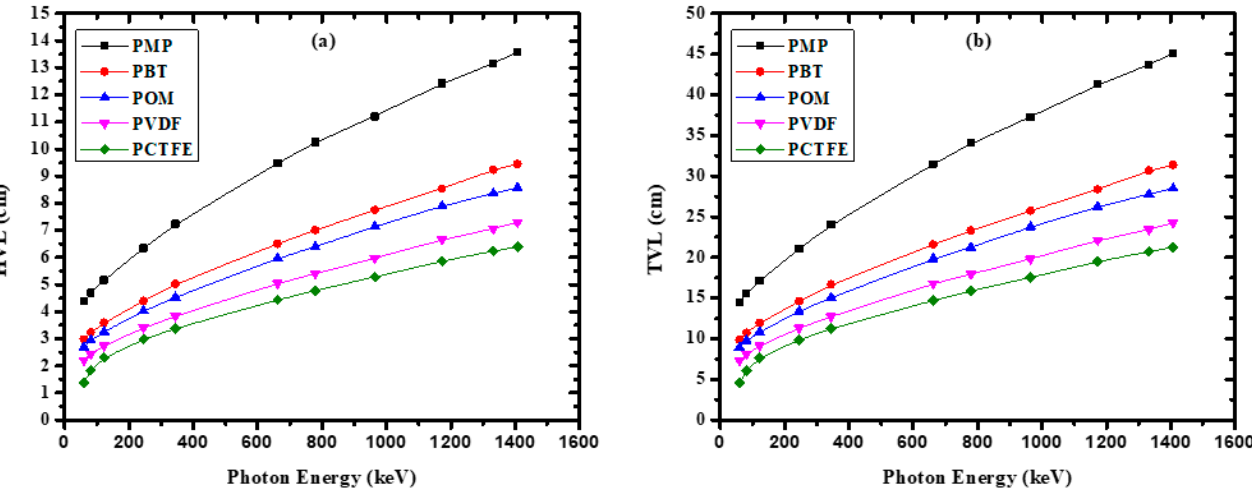
Figure 5. The variation of ( a ) half-value layer and ( b ) tenth-value layer with photon energy for the investigated polymers.